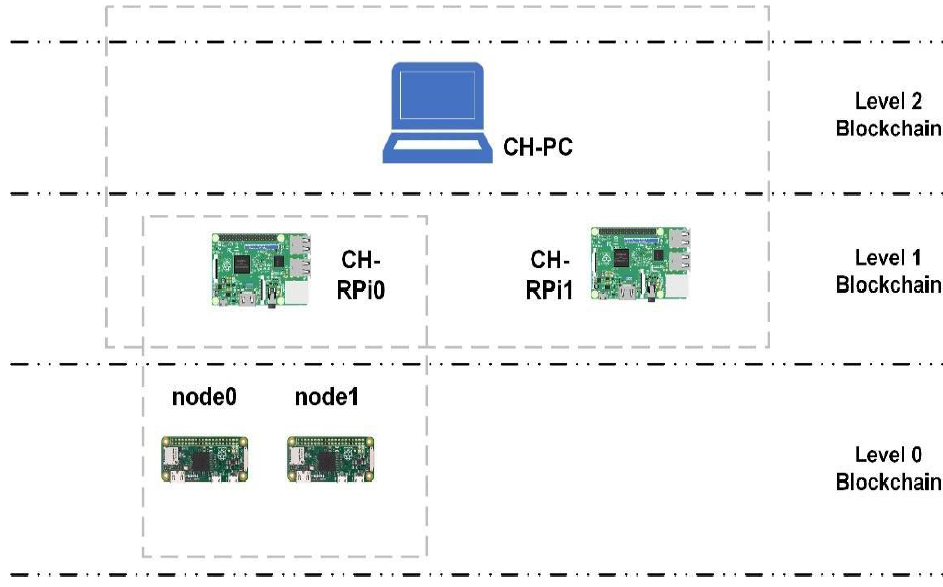
Figure 8. Test network.